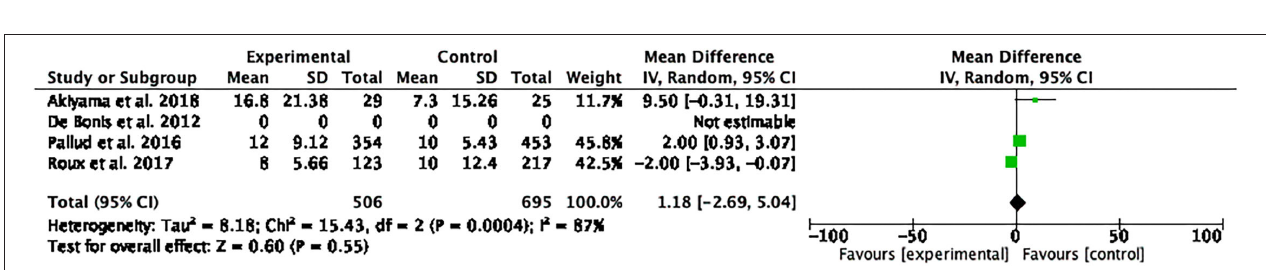
FIGURE 3 | Foster plot—progression-free survival ( PFS ). The analysis of meta-data demonstrated that there were no significant differences between the two treatment groups in terms of PFS , even though a high heterogeneity should be